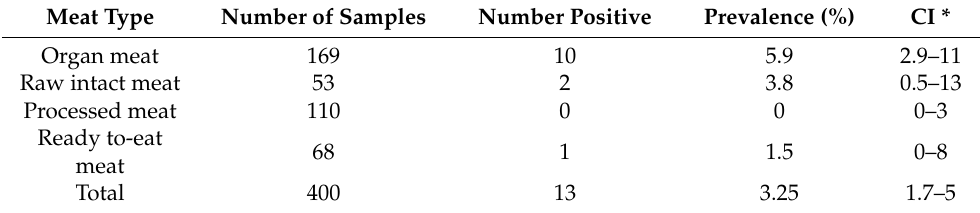
Table 2. Prevalence of S. aureus from beef-based products in selected districts from KZN.